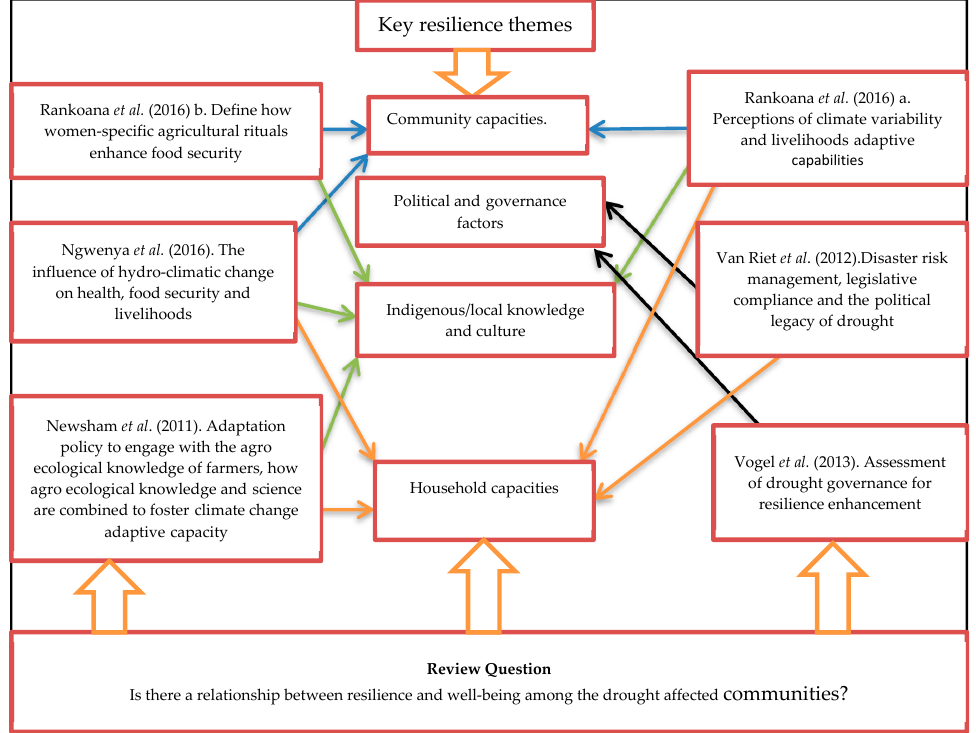
Figure 3. The synthesis of qualitative resilience themes adopted from Reference [46].